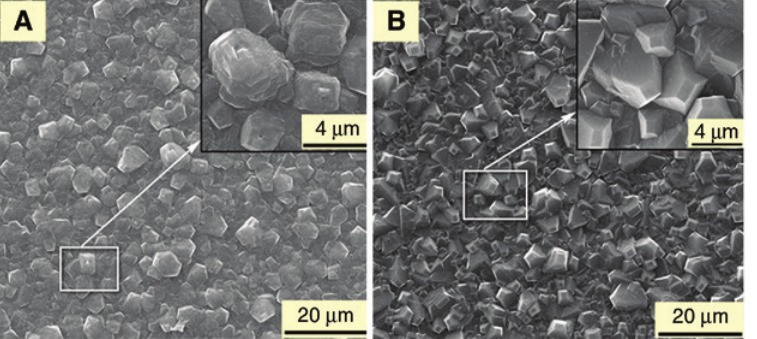
Figure 10: SEM of oxygen plasma etched diamond obtained at various gas flow rates (sccm). (A) O